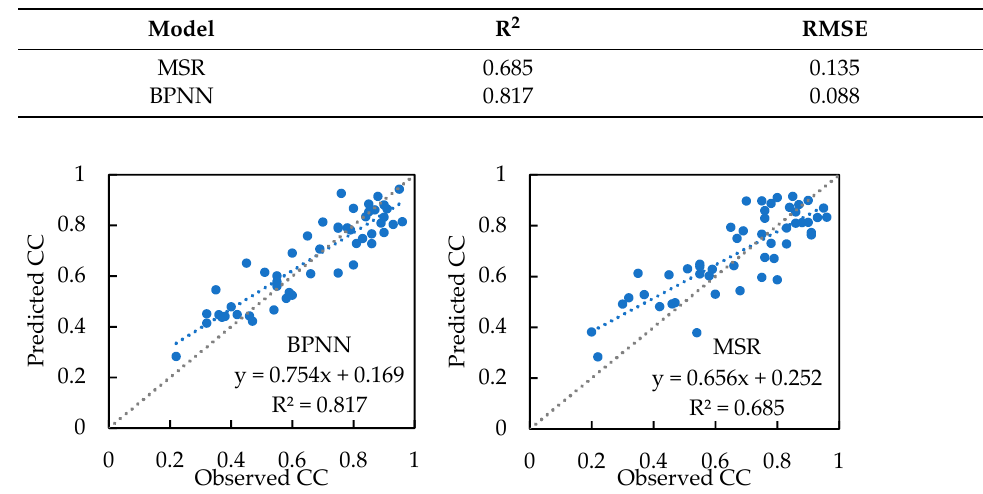
Figure 4. Scatter plots of measured values of canopy cover and estimated values of modeling points. Table 15. A comparison of modeling accuracy.